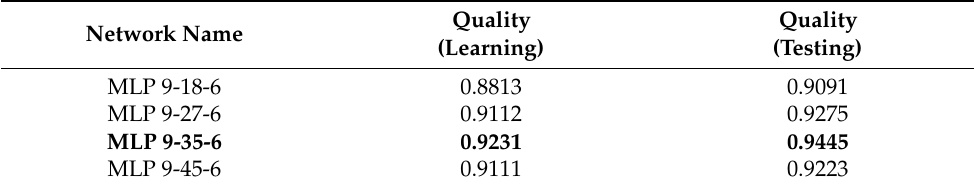
NS—ANN2 Structure, AH—Activation function in the hidden layer, AO—Activation function in Table 5. Selected ANN2 quality assessment (bolded is the best). the output layer. Table 5. Selected ANN2 quality assessment (bolded is the best).